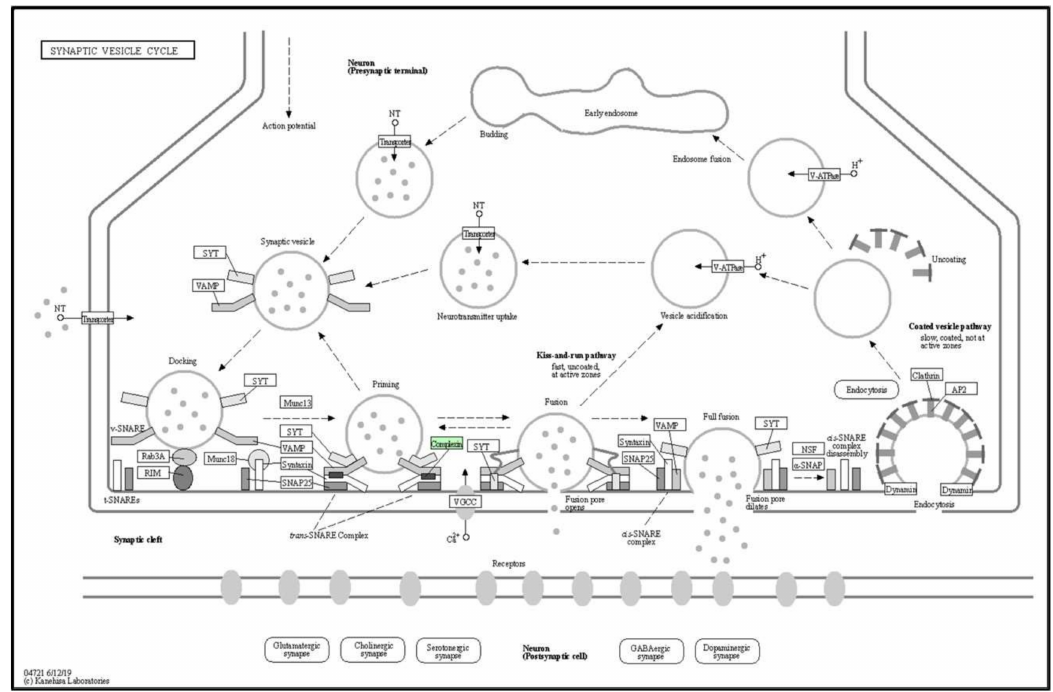
Figure 11. Complexin 2 in green box was mapped onto the synaptic vesicle cycle pathway (04721) generated by KEGG PATHWAY (Organism: Danio rerio ). Solid arrows represent molecular interactions or relations whereas dashed arrows represent indirect links or unknown